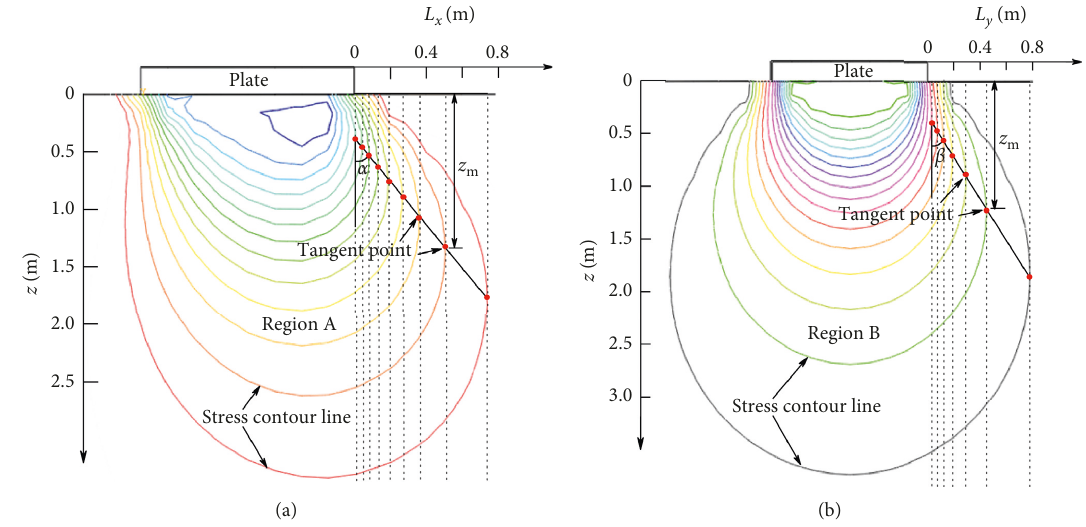
Figure 19: Additional stress contour lines in external regions: (a) region A; (b) region B.